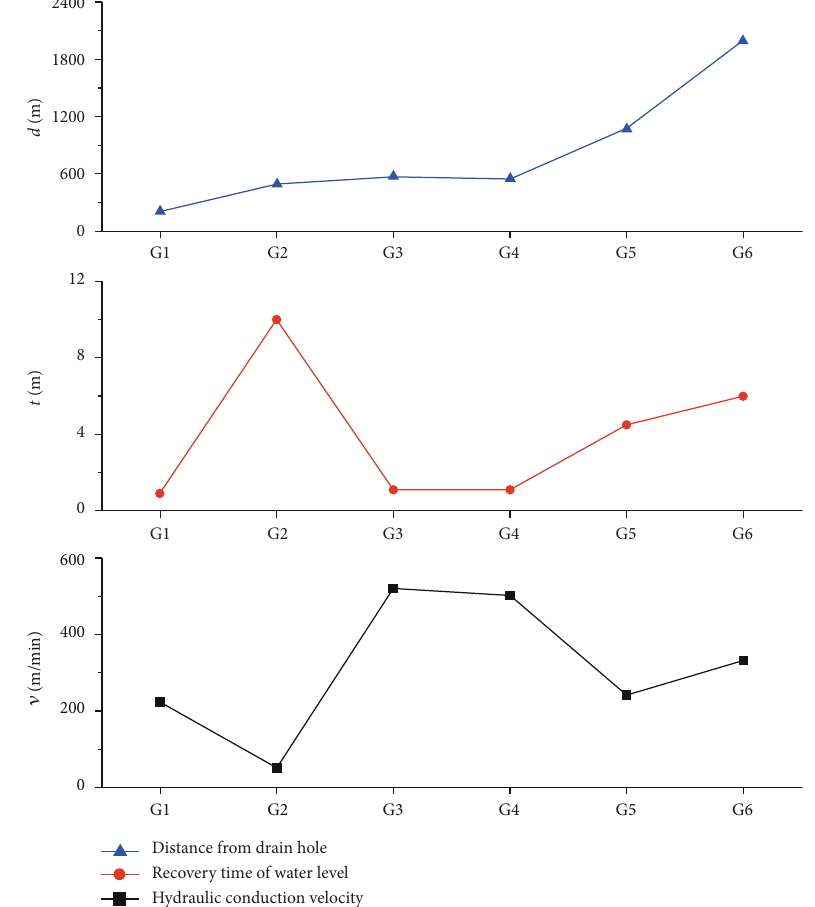
Figure 9: Results of water drainage